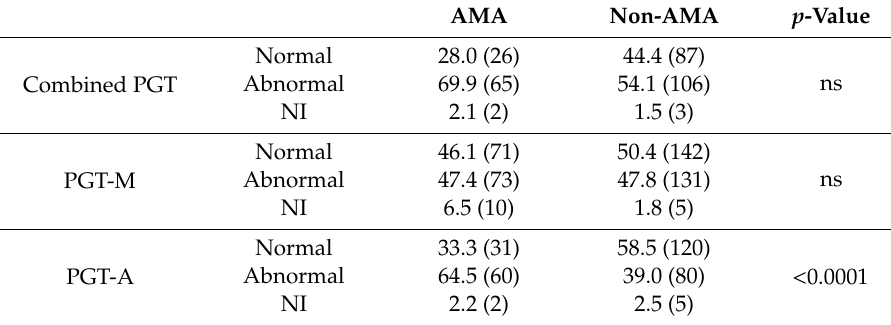
Table 4. Comparison of results per embryo in AMA and non-AMA groups [% (n)]. AMA